Question: What does this figure show? Answer in one sentence.
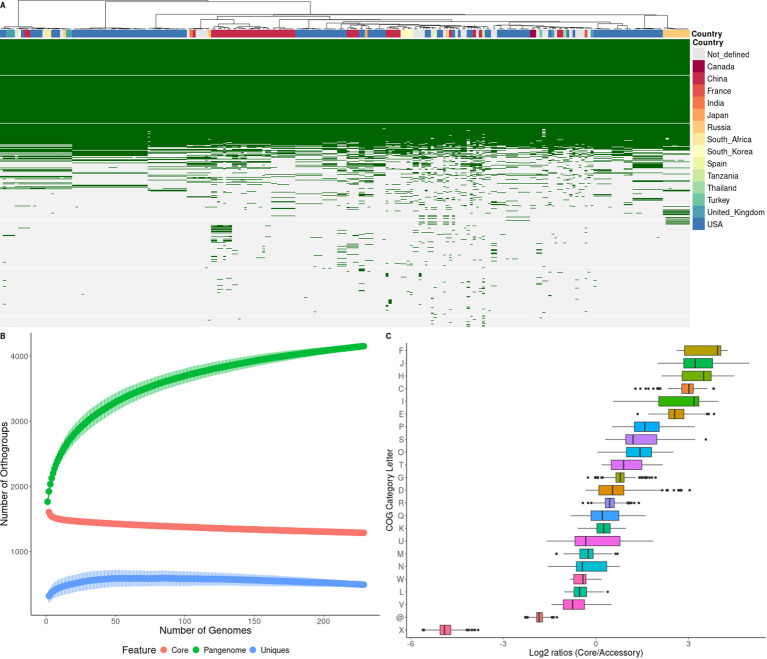
Answer: Pangenome analysis of B. bifidum utilizing 229 high-quality genomes (including the 900791 strain). (A) Ortholog conservation heatmap for the genomes according to their geographical origin, clusterized their shared gene family profile. (B) Pangenome accumulation curve suggests that the pangenome for B. bifidum is open (gamma value = 0.16, according to Power Law equation). (C) Analysis for the Log2 ratios of the percentage of core/near-core (>= 95% prevalence) versus accessory (< 95% prevalence) genes for each COG category among pangenomes “(@” = no COG category). COG category descriptions are available on the COG Database website ( https://www.ncbi.nlm.nih.gov/research/cog ).